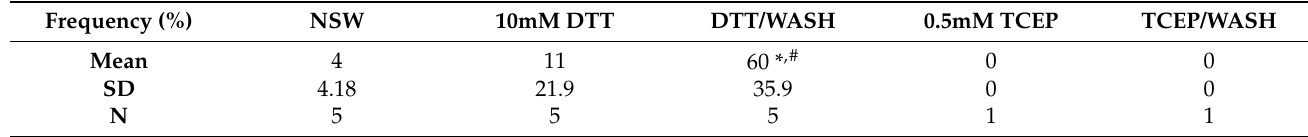
Table 1. Frequency of polyspermy (%) in P. lividus pretreated with various conditions. Frequency (%)